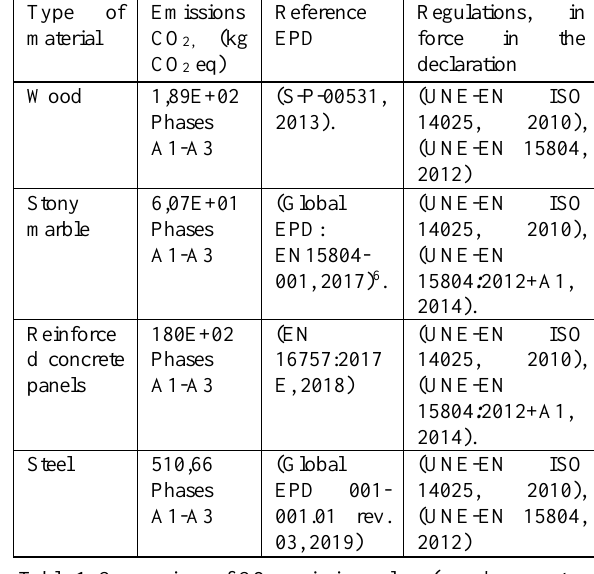
Table 1. Comparison of CO 2 emission values (wood, concrete - panels, stone-marble,